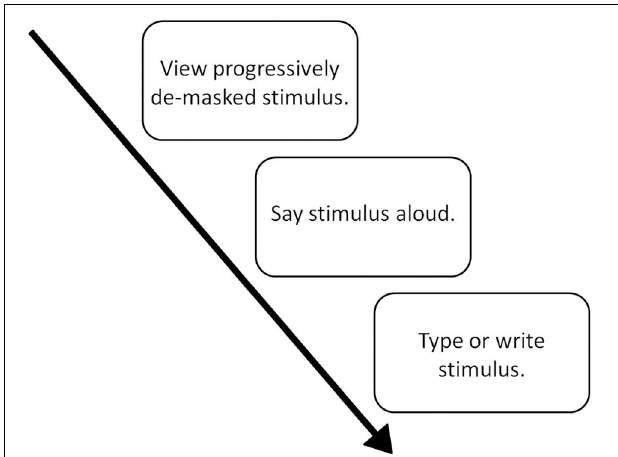
FIGURE 1 | The P3 paradigm.